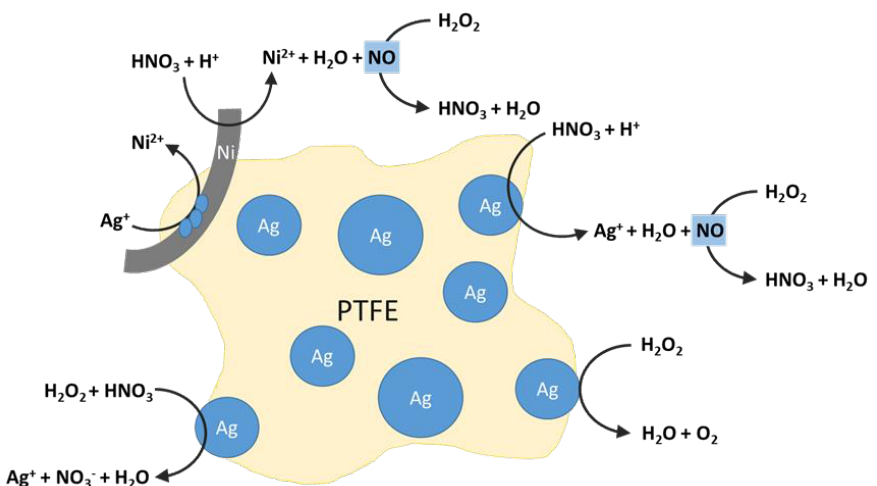
Figure 8. Schematic diagram for the possible reactions between silver, nitric acid, nickel, and hydrogen peroxide.